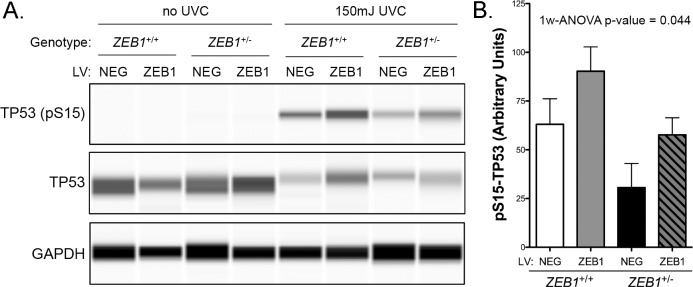
ZEB1 reduction may alter the CEnC response to UVC-induced apoptosis.(A) Western results showing levels of TP53 phosphorylated at Serine 15 in whole-cell lysates prepared from the ZEB1 CEnC lines treated either with 0 mJ or 150 mJ of UVC. Representative results from three independent experiments are shown. Detection of total TP53 and GAPDH were used as loading controls. (B) Bar graph representing abundance of pS15-TP53 normalized for loading. Data are represented as the mean ± SEM (n = 3). Statistical analysis was performed using one-way ANOVA with post-hoc Tukey test.